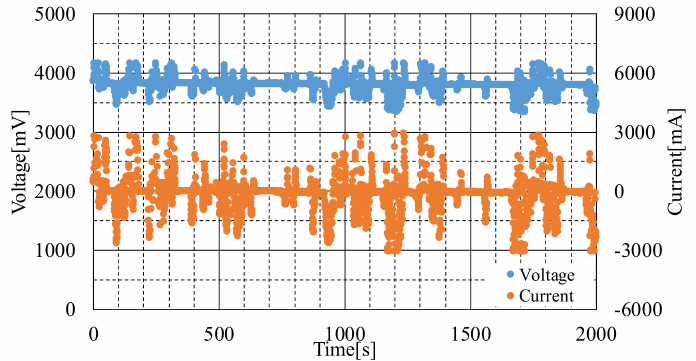
Figure 21. Scaled simulation per Li-ion cell by EV driven